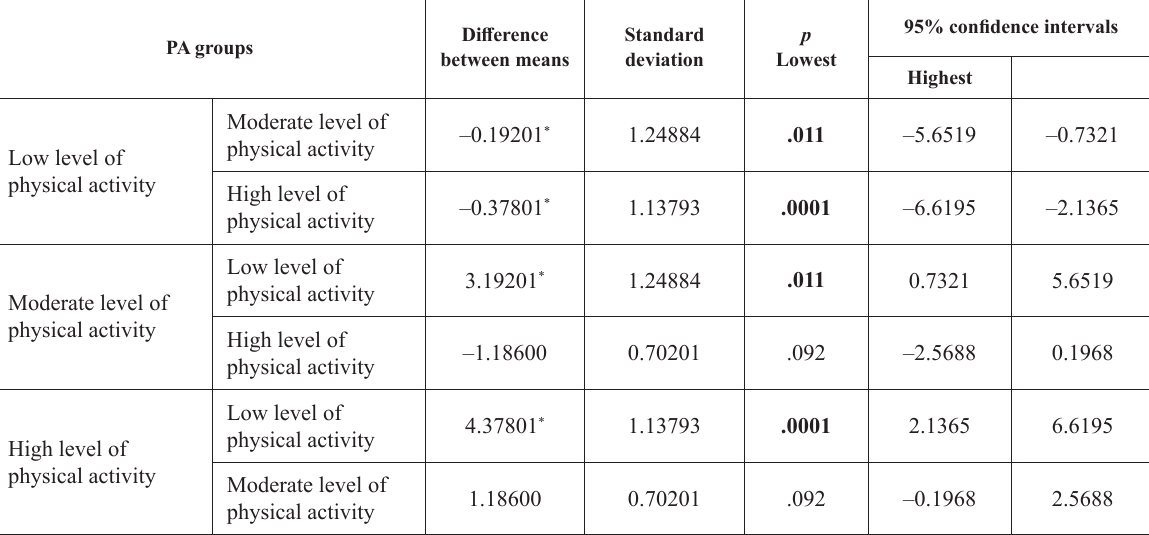
Table 10. Differences in nervous tension and stress assessments for subjects with low, moderate and high levels of physical activity